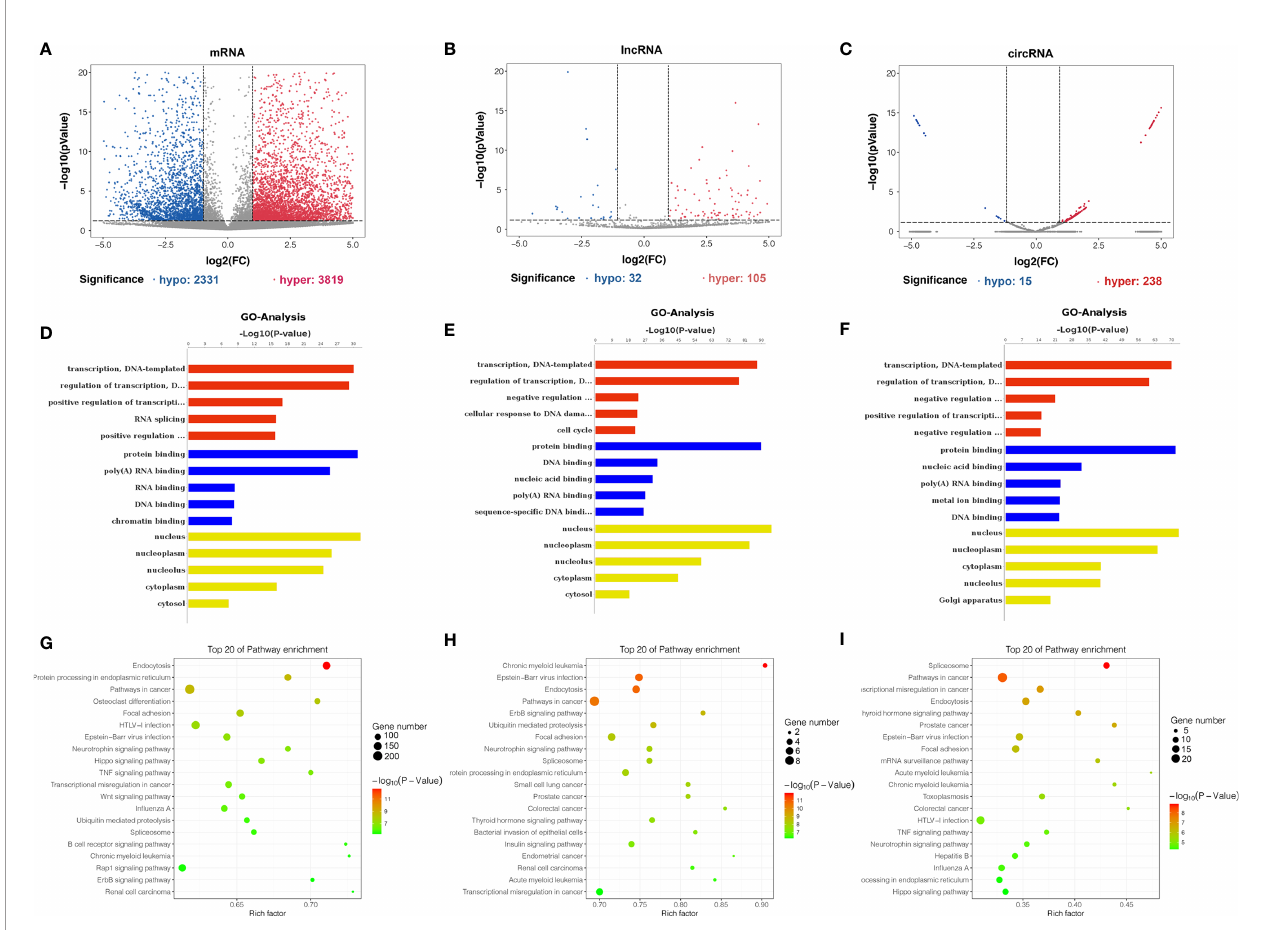
FIGURE 4 | Gene ontology and KEGG pathway analyses of genes harboring differentially methylated N6-methyladenosine sites. (A – C) Volcano plots showing differentially m 6 A-modi fi ed mRNAs (A) , lncRNAs (B) , and circRNAs (C) based on |log2FC| > 1 and p-value < 0.05. In volcano plots, red blots represent hypermethylation and blue blots represent hypomethylation. (D – F) Gene ontology functional enrichment analysis results of differentially methylated m 6 A sites- contained mRNAs (D) , lncRNAs (E) and circRNAs-associated (F) genes. (G – I) KEGG pathway analysis results of differentially methylated m 6 A sites-contained mRNAs (G) , lncRNAs (H) , and circRNAs-associated genes (I)